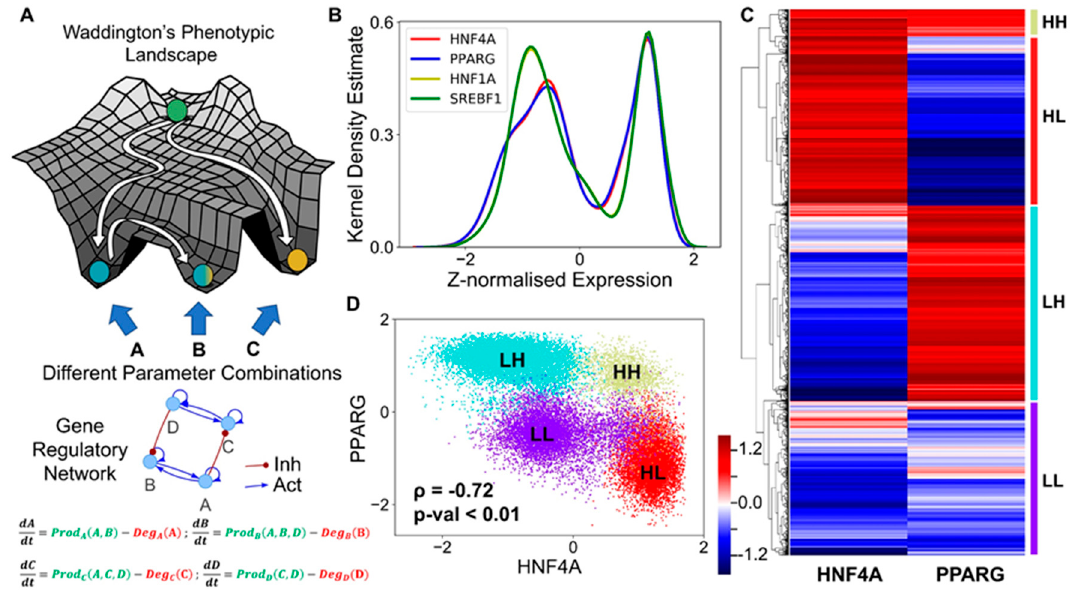
Figure 2. Core regulatory network may enable multiple phenotypes. (A) Schematic of Waddington’s phenotypic landscape highlighting the possibility of multiple states as a result of the underlying gene regulatory network, the dynamics of which can be modeled by a set of ordinary differential equations representing the interactions among them as shown below. (B) Kernel density plot showing the bimodal distribution of each component of the network, implying that each of the transcription factors (nodes) can exist in either a high (H) or a low (L) state. The x-axis shows the z-normalized log2 expression values of the given component from RACIPE analysis. (C) Heatmap showing the relative levels of HNF4A and PPARG and the resulting four clusters. The color bar represents the relative levels of the individual components (z-normalized log2 expression values). (D) Scatter plot showing the existence of the four distinct clusters (defined based on hierarchical clustering) as the four states based on relative levels of HNF4A and PPARG (z-normalized log2 expression values). Spearman’s correlation was performed to obtain the correlation coefficient ( ρ ) and the corresponding p-value (p-val).